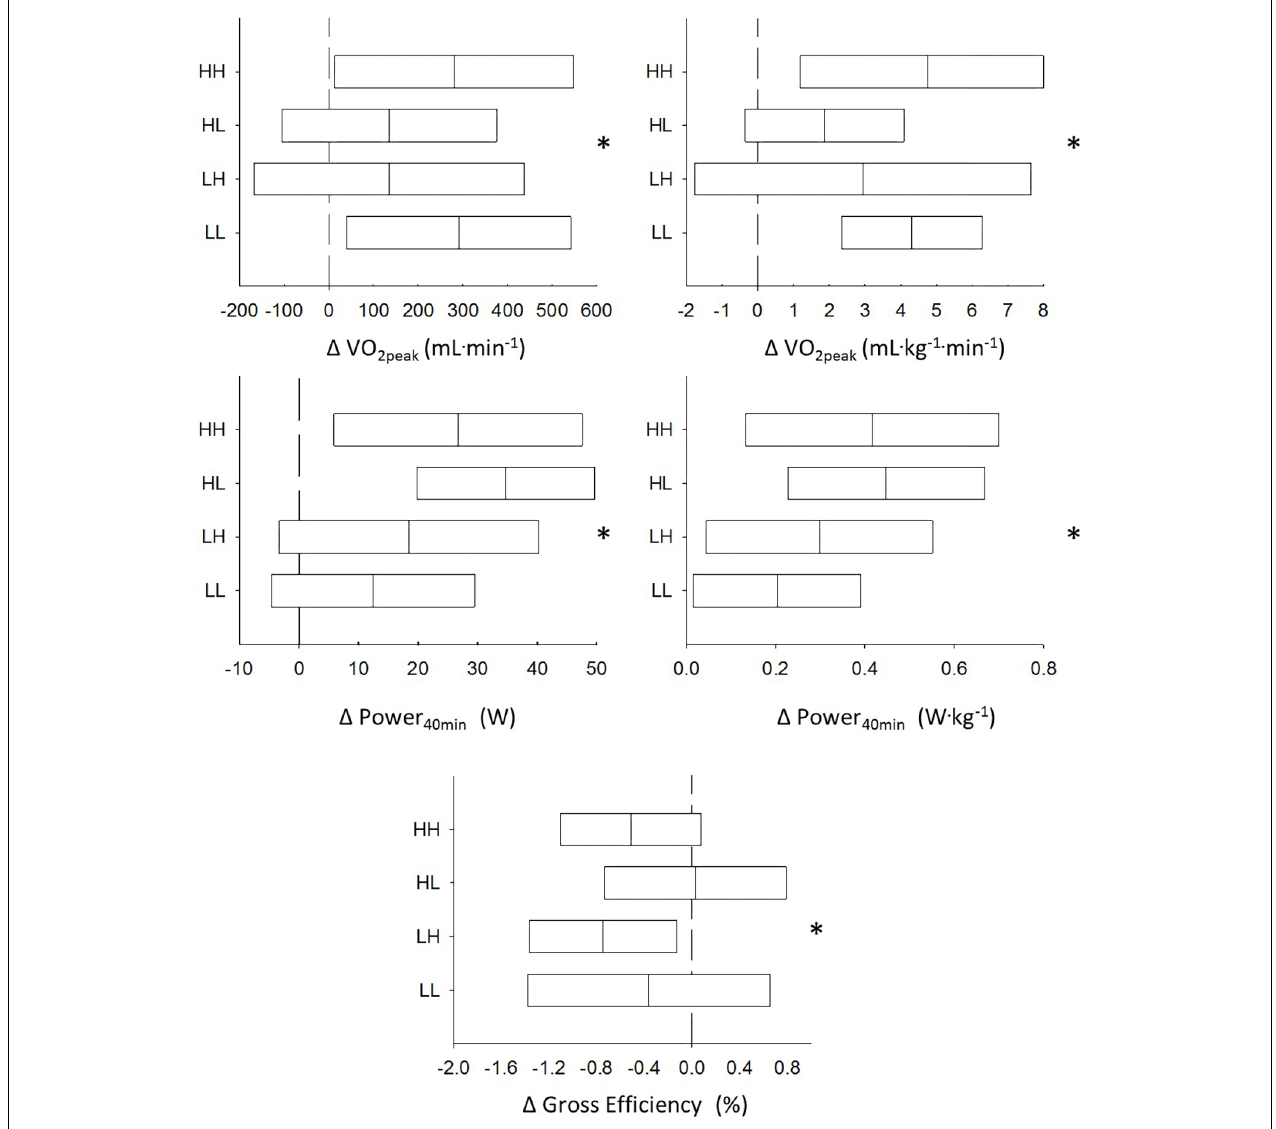
FIGURE 8 | Group responses from the pre-test to the post-test for the HH (high ˙ V O 2peak and high efficiency), HL (high ˙ V O 2peak and low efficiency), LH (low ˙ V O 2peak and high efficiency), and the LL (low ˙ V O 2peak and low efficiency) groups for ˙ V O 2peak , time trial performance and gross efficiency (GE). ∗ Indicates a significant main effect of the training